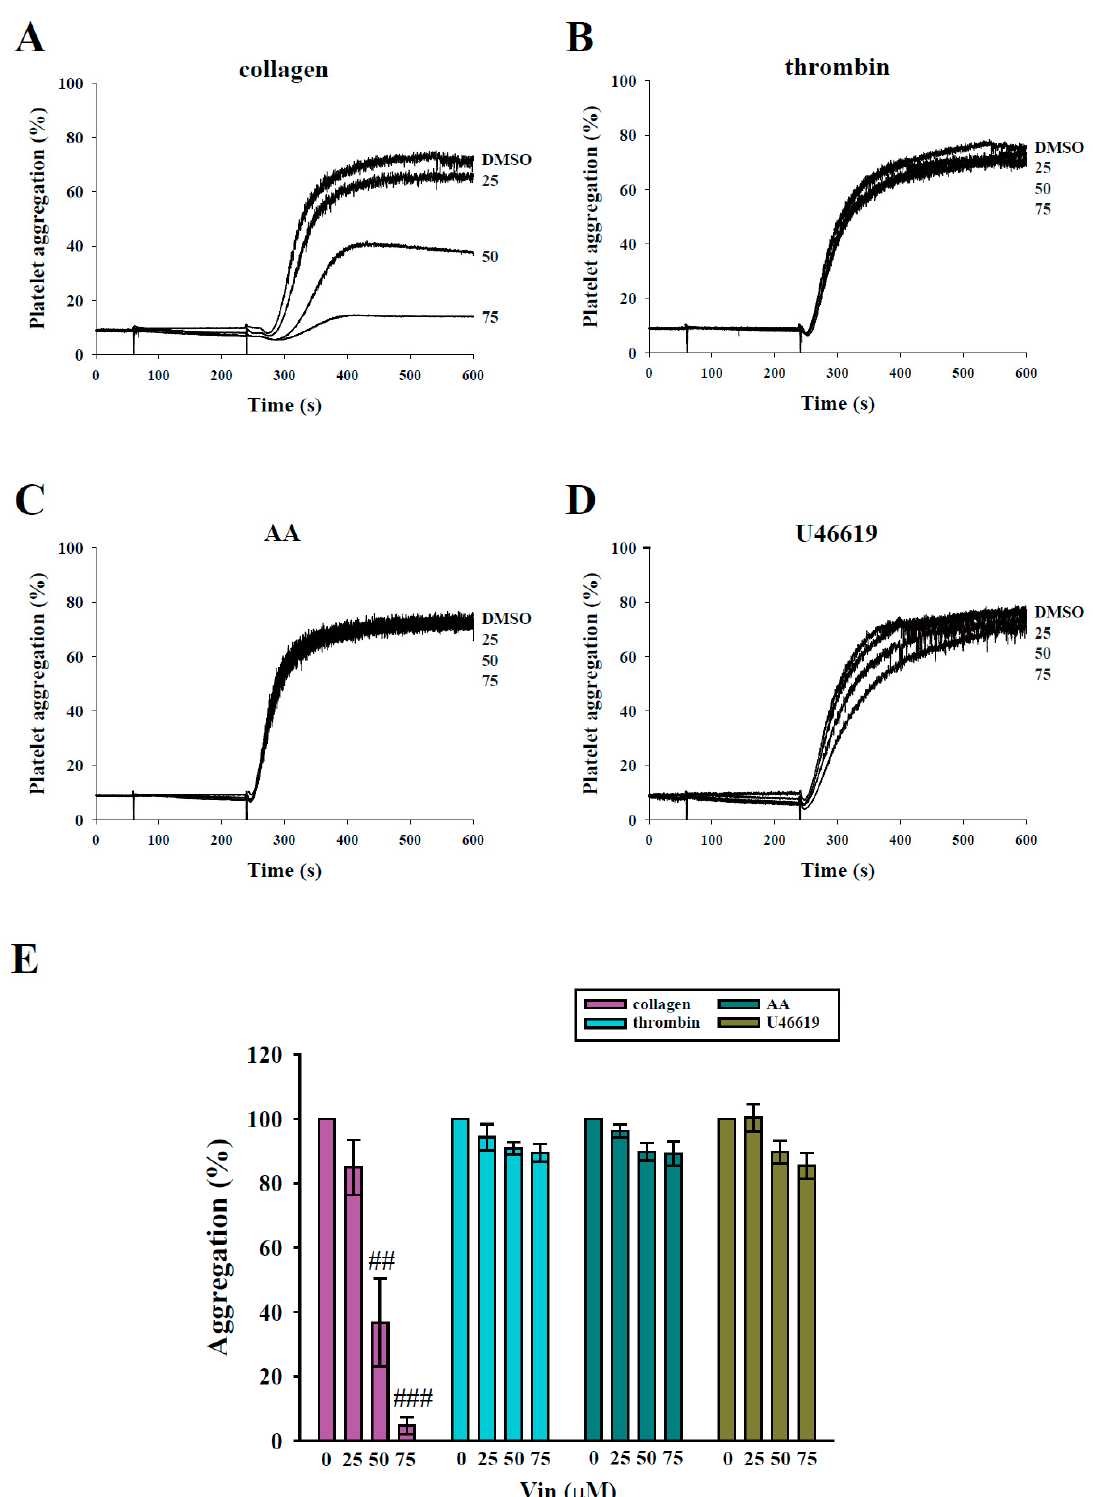
Figure 2. Effects of vincristine on platelet aggregation stimulated by various agonists in human platelets. Washed platelets (3.6 × 10 8 cells/mL) were treated with vincristine (25–75 μ M) or DMSO before the addition of 1 μ g/mL collagen ( A ), 0.02 U/mL thrombin ( B ), 60 μ M AA ( C ), and 1 μ M U46619 ( D ). Panels A – D indicate the platelet aggregation curve, and panel E displays the statistical analysis of platelet aggregation (percent). Data in ( E ) are presented as mean ± standard error of the mean ( n = 3). ## P < 0.01 and ### P < 0.001 compared with the DMSO (solvent control) group.